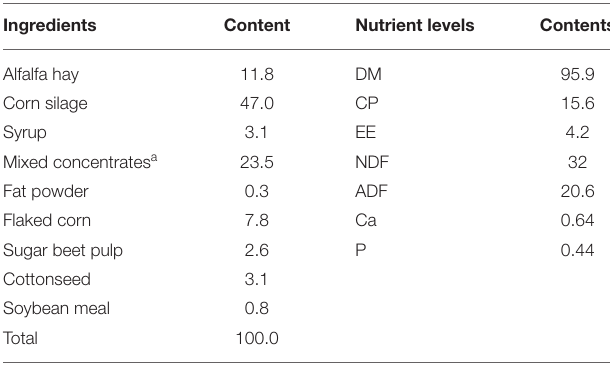
TABLE 1 | Ration composition and nutrient levels (dry matter basis,